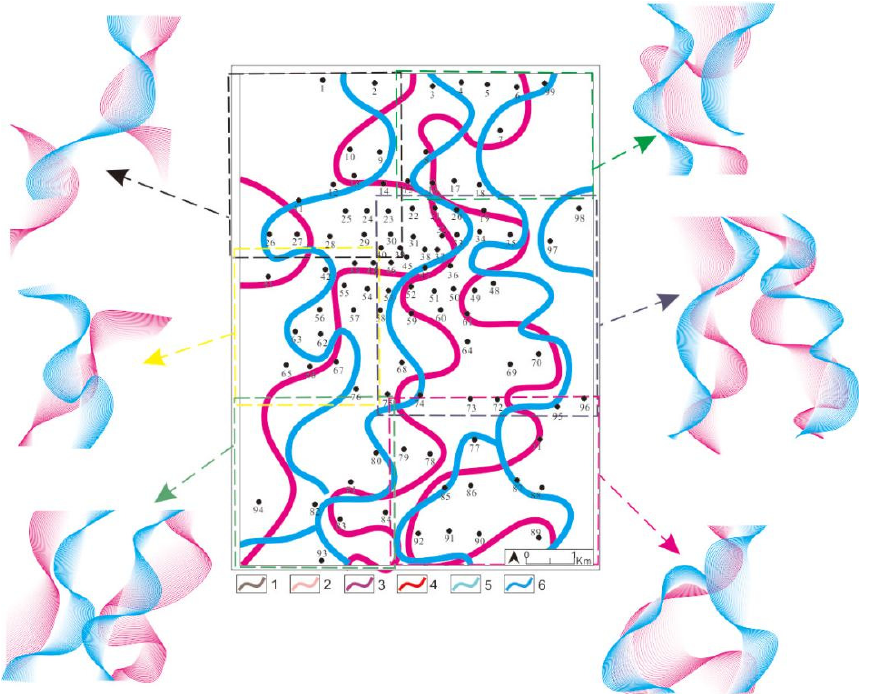
Figure 20. Migration modes of ancient planform of S 11 monolayer in the Sulige gas field of Ordos Basin, China. Basin,